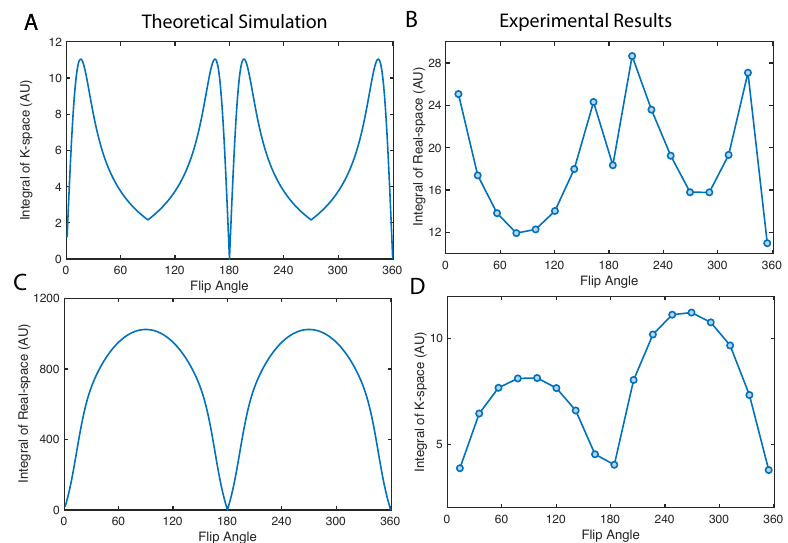
Figure 6. Total signal in k- and real- space as a function of flip angle. ( A , B ) The integration of absolute value in k-space is simulated and measured using the diamond particle phantom. ( C , D ) Display the integration of absolute value in real-space. The simulations are conducted assuming a uniform profile in real-space, i.e., ρ ( x , y ) = constant, in which case only the effect of magnetization factor K is